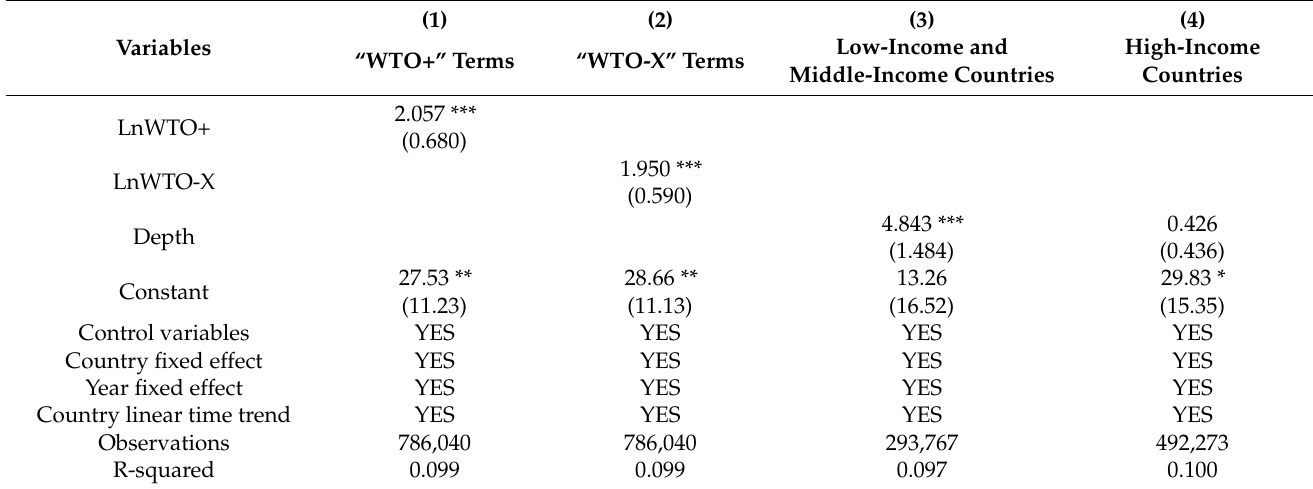
Table 8. Results based on different terms and different income